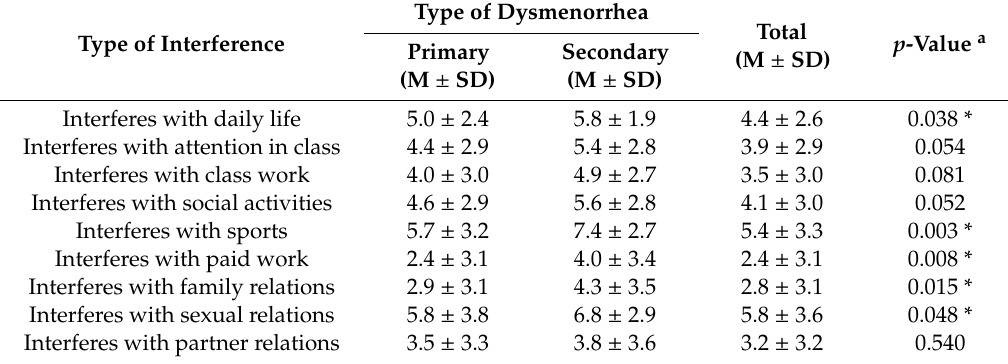
Table 3. Degree of interference reported by students with primary and secondary